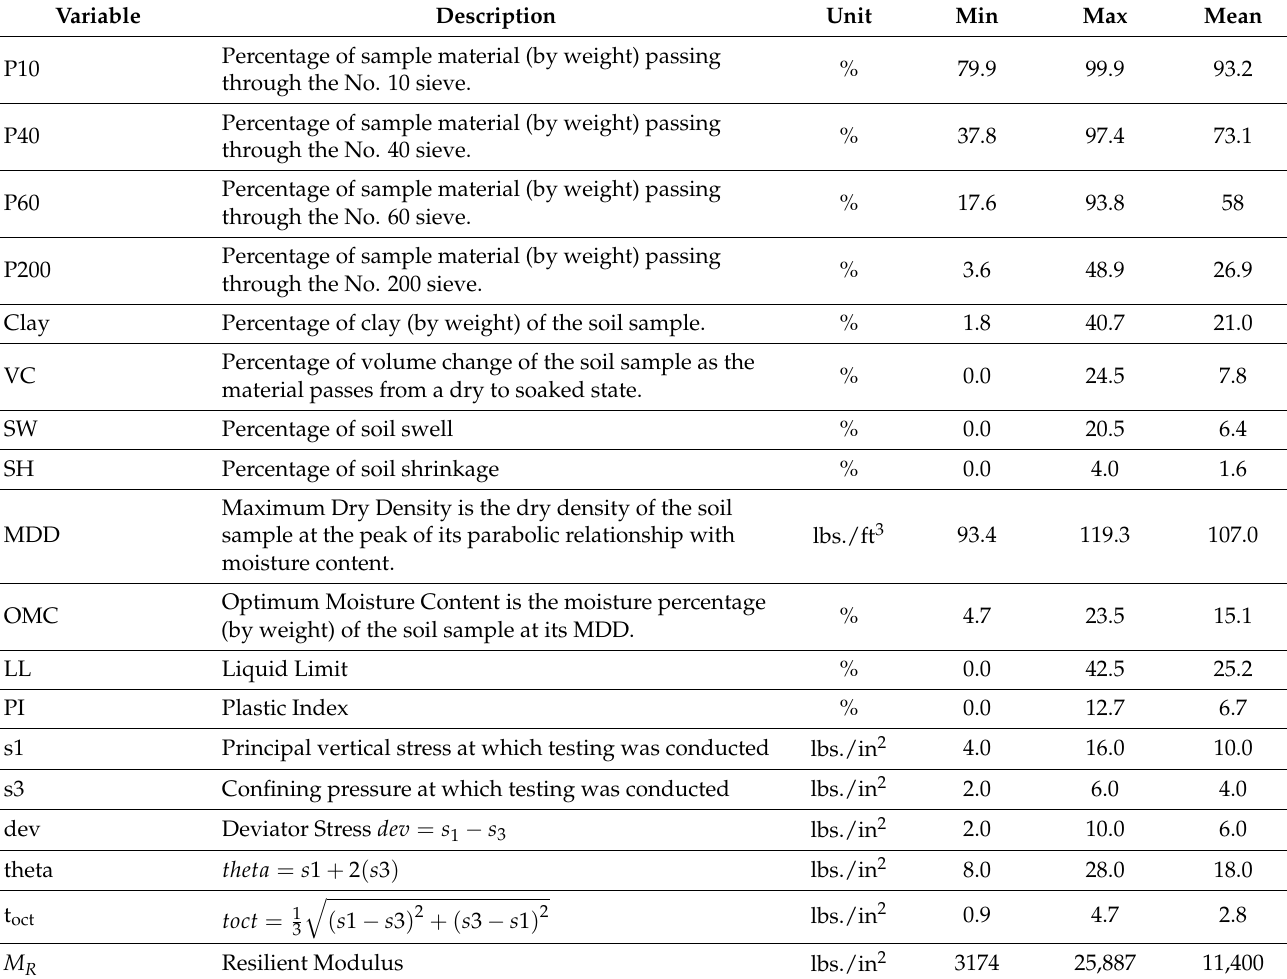
Table 2. Summary of